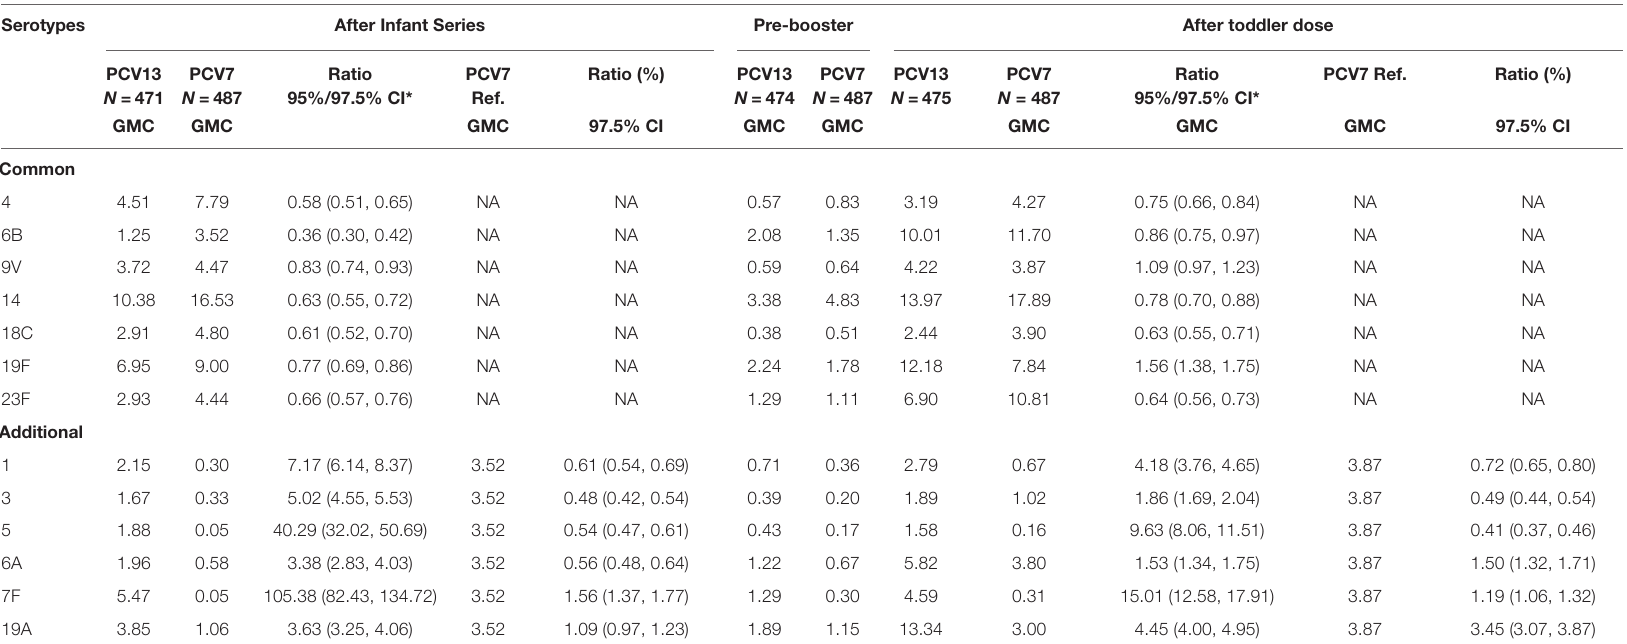
TABLE 4 | Comparison of pneumococcal IgG GMC ( µ g/ml) after the administration of the infant series, pre-booster, and toddler doses.